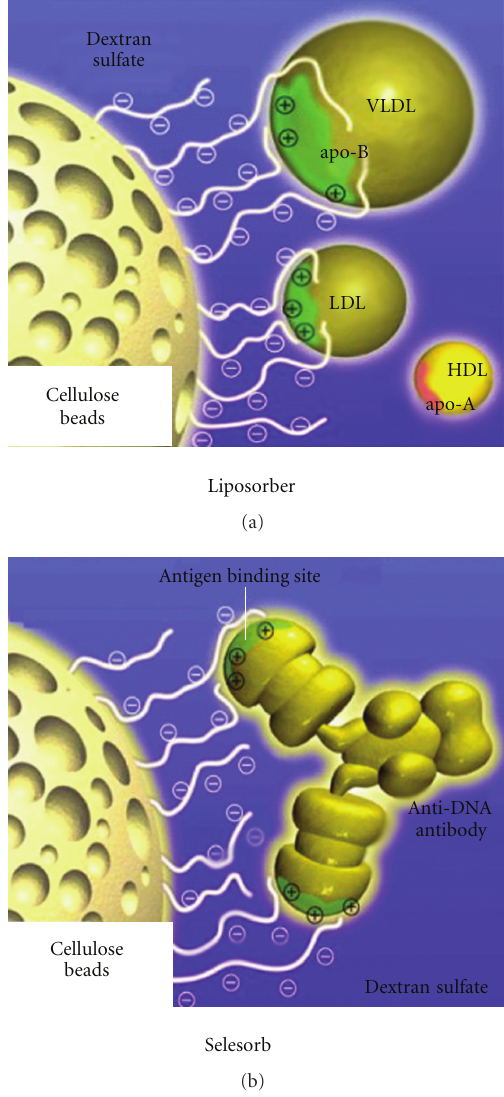
Figure 13: The schema of the Liposorber and Selesorb. Apo- B, anti-DNA antibody, immune complex, or antigen-recognizing site on anticardiolipin antibody is charged with positive charge. Liposorber and Selesorb include cellulose beads with the negative charge of dextran sulphate. The a ffi nity between negative charge of these columns and these positive charged etiological substances was mainly caused by the ionic